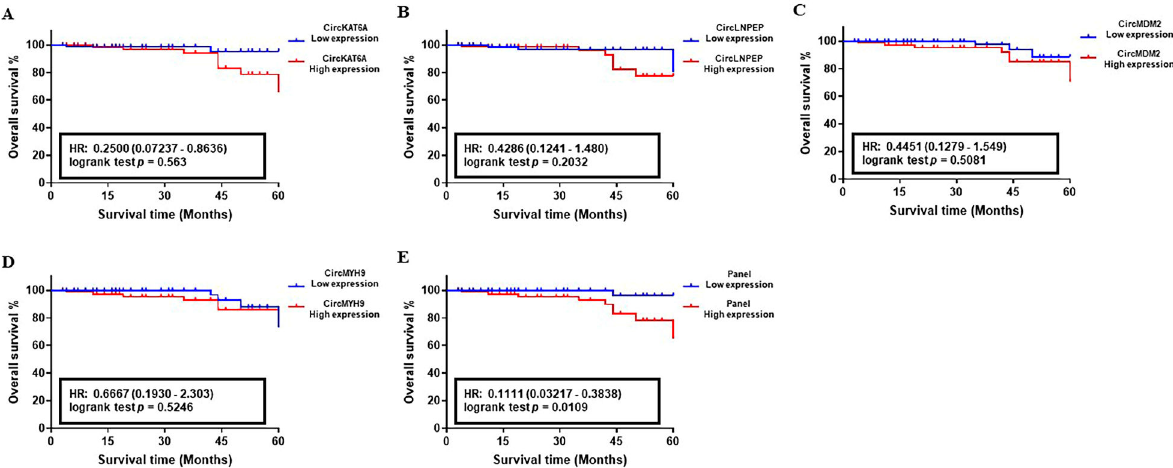
Figure 5. Correlation between the abnormal expression of candidate circRNAs and overall sur- vival (OS) of CLL in the training set ( n = 100). ( A – D ) Survival impact of CircKAT6A, CircLNPEP, CircMDM2, and CircMYH9 as individual biomarkers, and ( E ) in the form of a panel in CLL. Kaplan- Meier analysis indicated a reverse correlation between the high level of combined circRNAs and the poor survival of CLL patients in training set I.